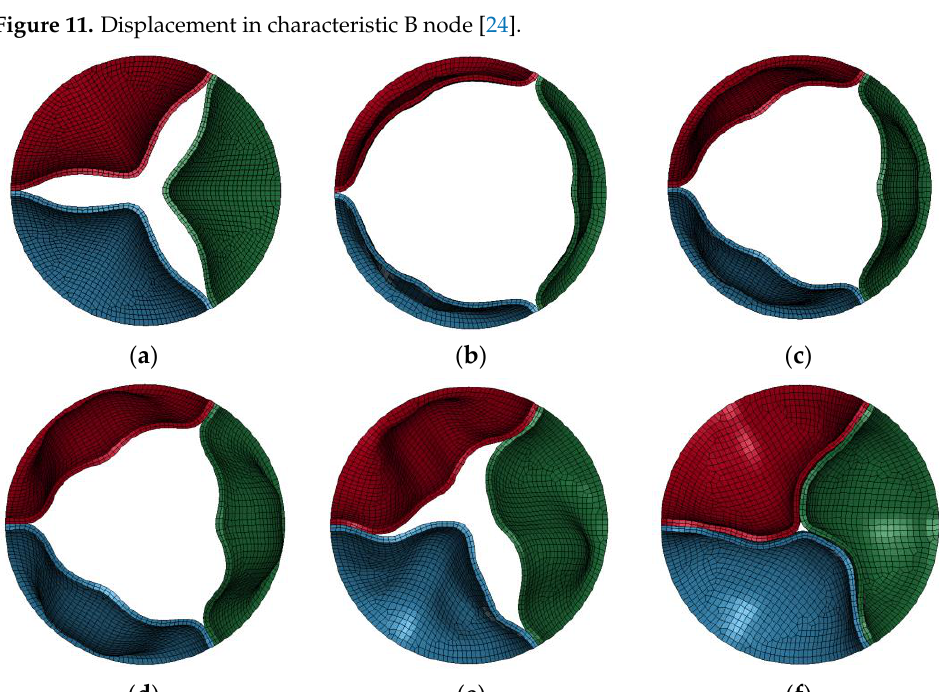
Figure 12. Deformation behaviors of the leaflets without hysteresis. ( a ) t = 0.06 s, ( b ) t = 0.08 s, ( c ) t = 0.2 s, ( d ) t = 0.32 s, ( e ) t = 0.33 s, and ( f ) t = 0.34 s.